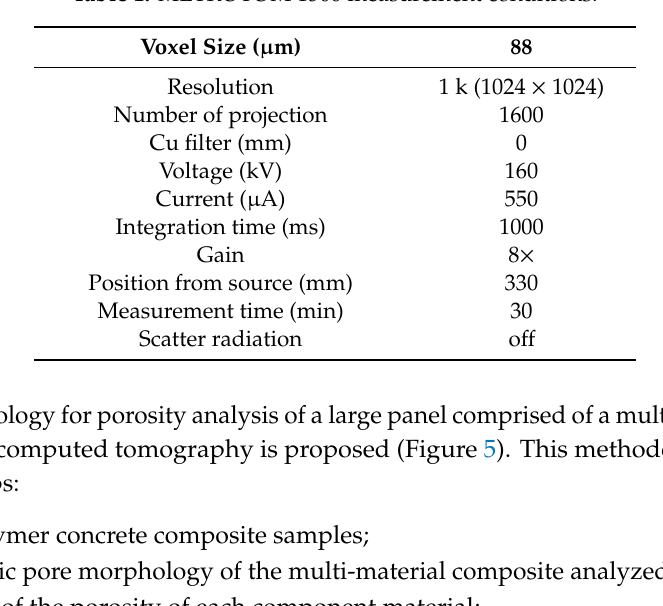
Figure 4. ( a ) Layout of the X-ray CT analysis. ( b ) Precision digital scale. Table 1. METROTOM 1500 measurement